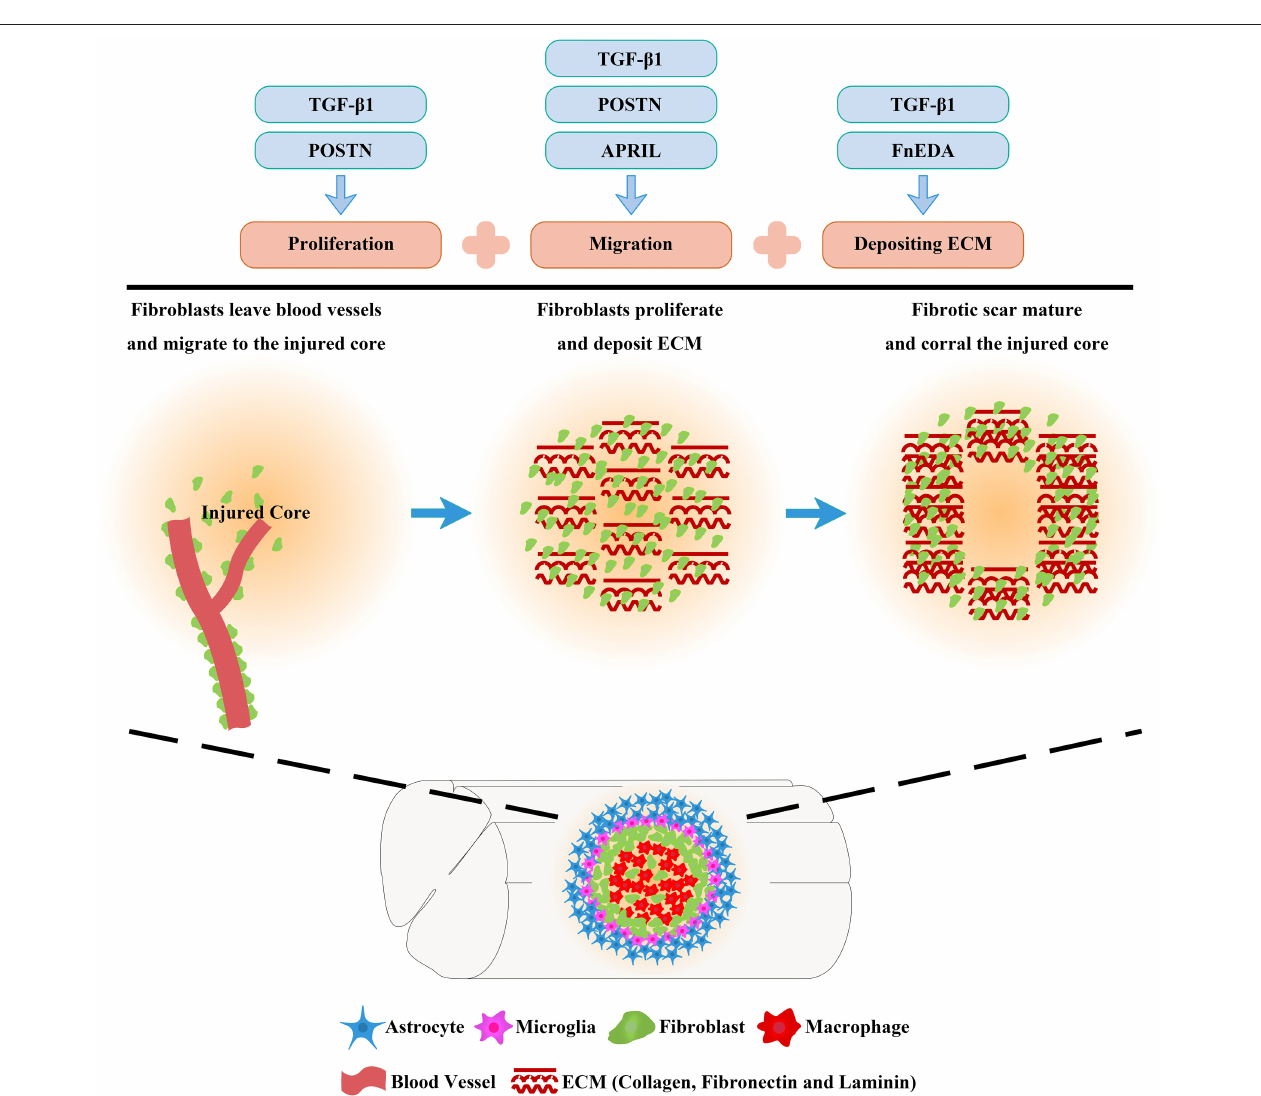
FIGURE 3 | Molecular mechanisms of fibrotic scar formation after spinal cord injury. After SCI, fibroblasts leave blood vessels and then proliferate, migrate, and aggregate at the injured area, depositing extracellular matrix (ECM) to form fibrotic scar that corrals the injured core. Migration, proliferation, and ECM deposition are the key processes by which fibroblasts form the fibrotic scar, and the mechanisms can be used as treatment targets for SCI.